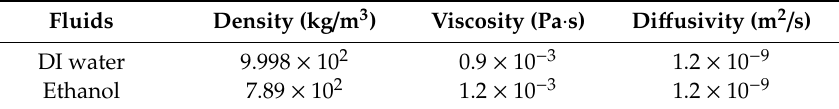
Figure 1. Three types of microchannel-based mixers. ( a ) Y-shaped: straight microchannels with no meander structure. ( b ) S-shaped: meander microchannels for increasing contact area/time of diffusion. ( c ) S-shaped with embedded baffle: meander microchannels with embedded baffle obstacles for inducing chaotic convection effects by altering the geometric surface of the microchannels.( d ) Dimensional drawing for major structural features. Table 2. Parameters of fluids in the